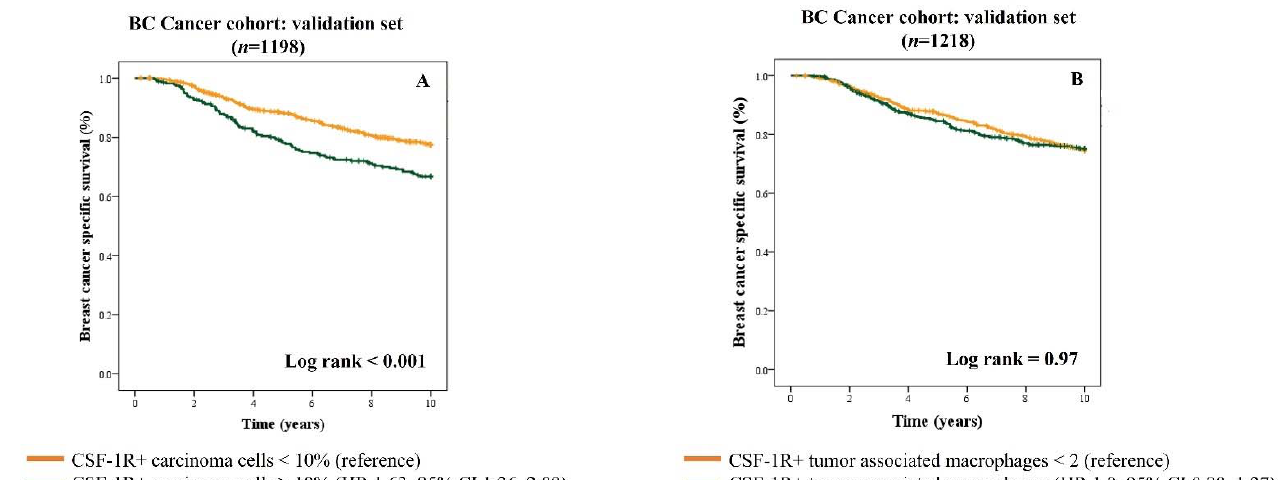
Figure 3 . Kaplan–Meier survival curves showing breast cancer-specific survival in the validation set of BC Cancer series stratified by CSF-1R+ carcinoma cells ( A ) and CSF-1R+ tumor-associated macrophages ( B ). Prespecified subgroup analysis for CSF-1R-expressing carcinoma cells in ER-positive cases ( C ) and ER negative cases ( D ). Table 3 . Multivariate analysis for CSF-1R+ carcinoma cells in the validation set of BC Cancer cohort . Co-Variates in the Model